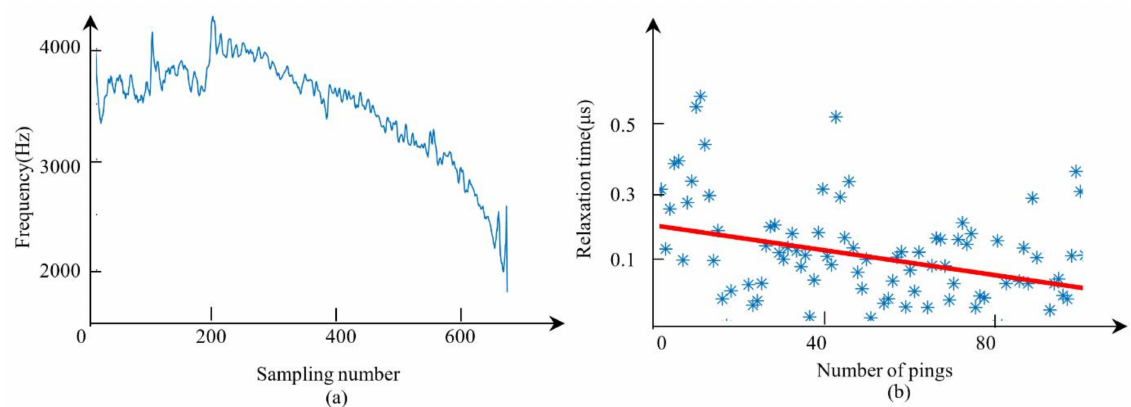
Figure 15. Illustration of the IF series using WVD and the relaxation time map. ( a ) The IF series. ( b ) The robust line fitting based on the relaxation time